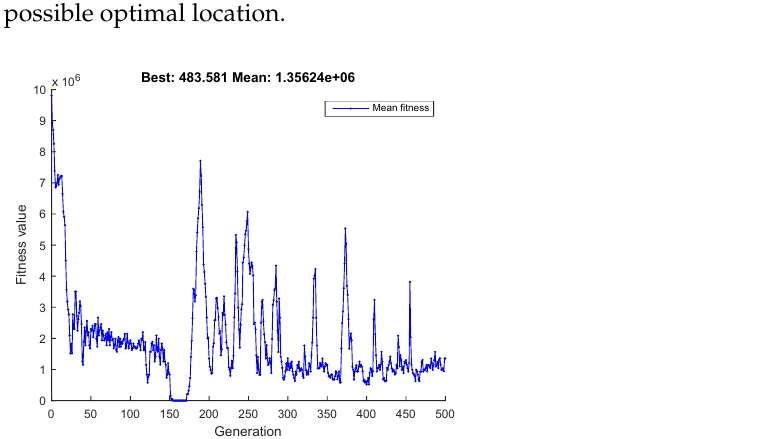
Figure 22. Suitability average in the optimization of the variables pos and pot without bars restriction. The initial evaluation function is f ( (cid:126) x ) = 1046.20 and the final evaluation function is f ( (cid:126) x ∗ ) = 483.58, obtained after 500 generations. There was an improvement in the voltage level of ≈ 53.77%, obtained by analyzing the value of the evaluation function. This improvement, when compared to the data shown in Table 7, reflects an increase of 43.65% of nodes with adequate voltage, a reduction of 29.21% of nodes with precarious voltage, and a reduction of 65% of nodes with critical voltage. The 10 DGPV inserted in the optimization process add up to pot total = 298.55 kVA of power injected into the grid and the electrical losses reduced from 13.08% to